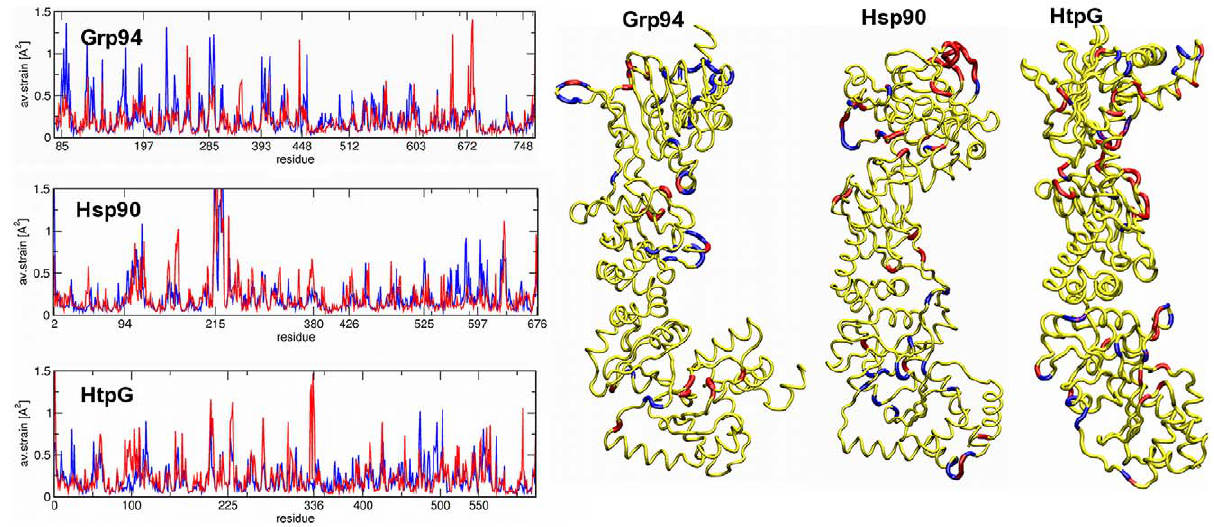
Figure 5. Geometrical strain analysis. Left panel, the residue based profile of average strain calculated over the time interval 20–100 ns for the three proteins in ATP-bound state (blue line) and in the ADP-bound state (red line). Right panel, protein monomers with average strain maxima shown in blue (ATP case) and red (ADP case).